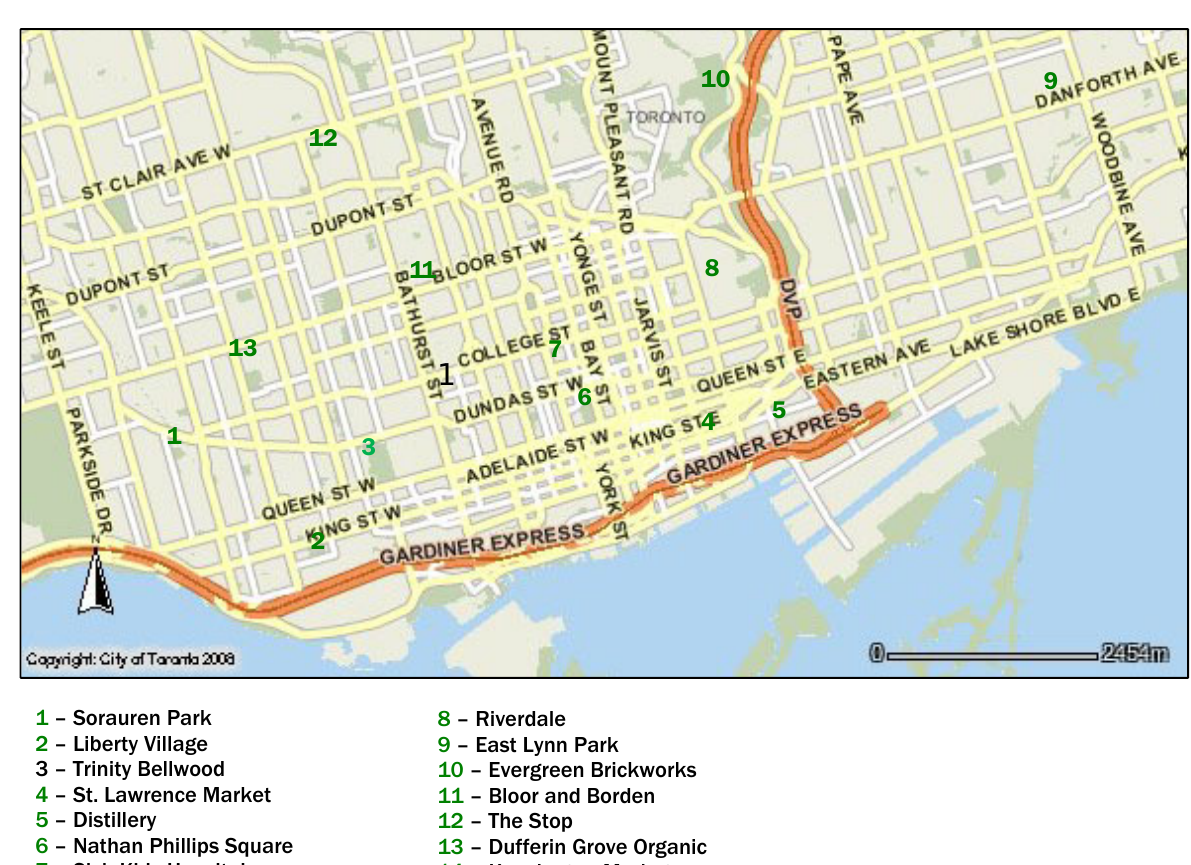
Figure 1. Toronto Core Farmers’ Markets (Approximate